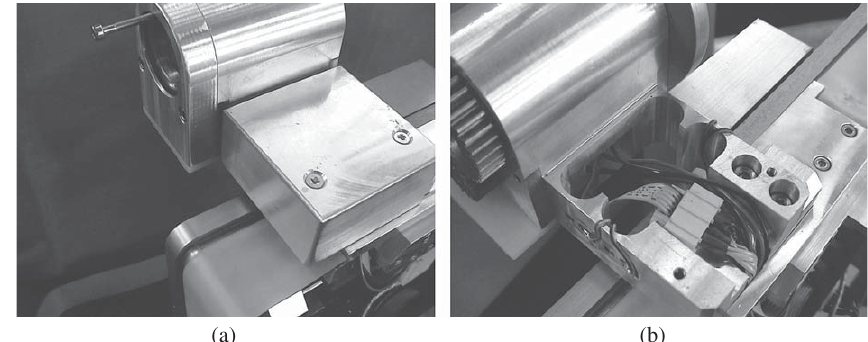
Fig. 10. Sensorized tool-holder. a) Load cell. b) Load cell layout.